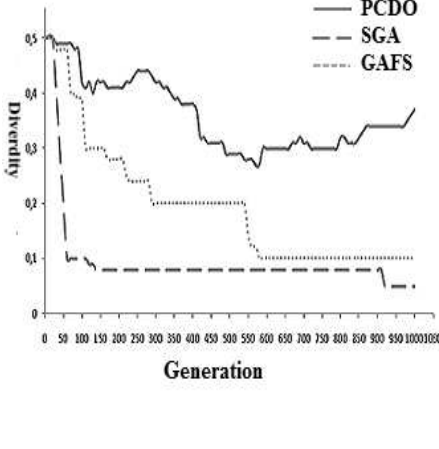
Fig. 3. Diversity